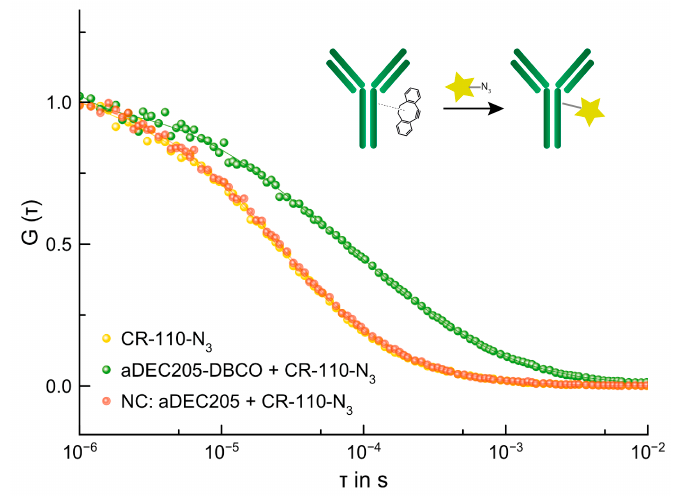
Figure 4. FCS: SPAAC of DBCO-modified aDEC205 and CR-110-N 3- fluorescence dye: yellow line: CR-110-N 3 : R h = 0.56 nm; green line: SPAAC of aDEC205-DBCO and CR-110-N 3 : R h = 5.8 nm (49%); red line: negative control: native aDEC205 and CR-110-N 3 : R h = 0.58 nm.